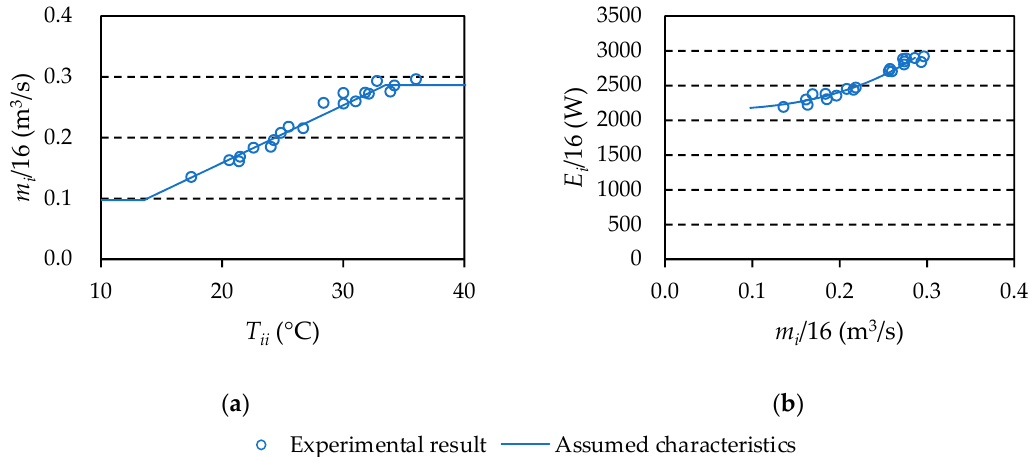
Figure 14. ITE characteristics with respect to ITE inlet temperature ( T ii ): ( a ) ITE airflow rate per rack for T ii and ( b ) ITE power consumption per rack for m i .